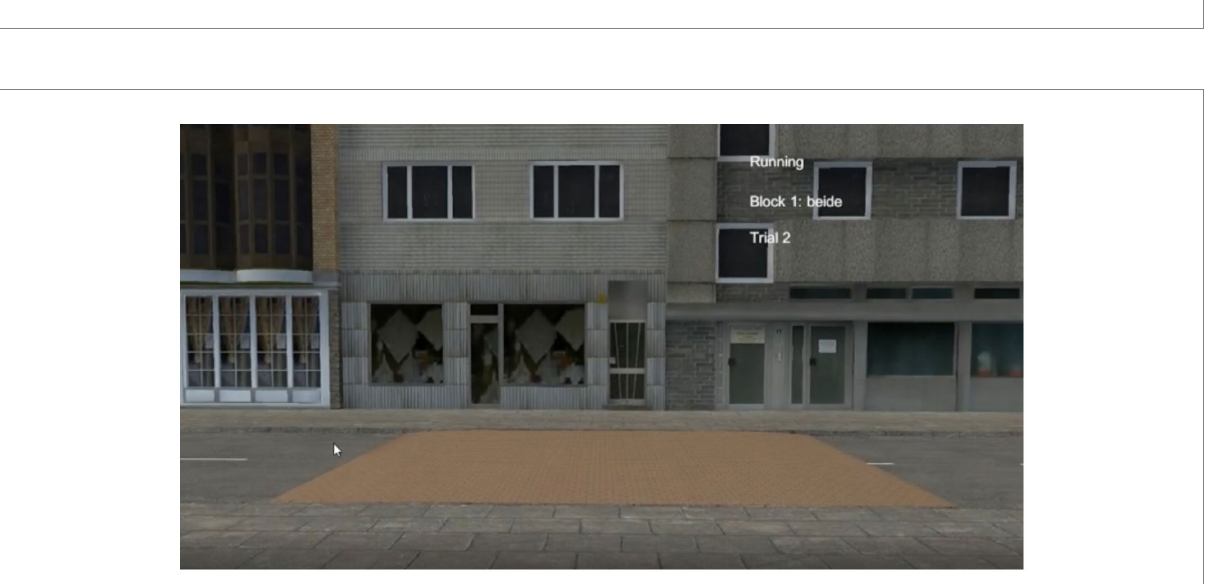
FIGURE 3 Street scene 2 of the VR